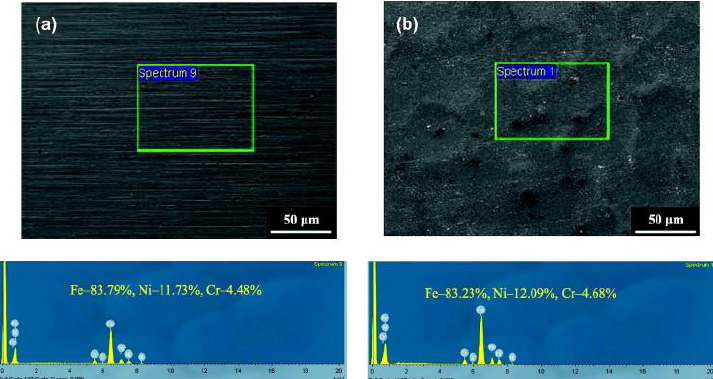
Figure 11. SEM and X-ray energy spectrum analysis (EDS) analyses of the high-frequency ultrasonic peening (HFUP)-free ( a ) and HFUP-treated ( b ) specimens. Reproduced from [56], with permission from Elsevier, 2013.